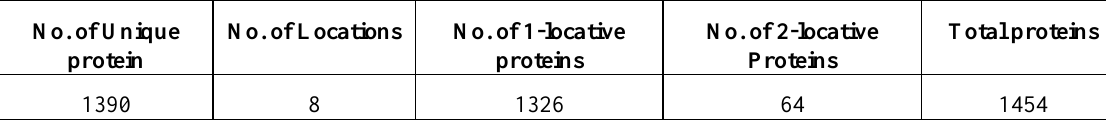
Table 1: Proteins in Gram Negative Dataset after preprocessing.